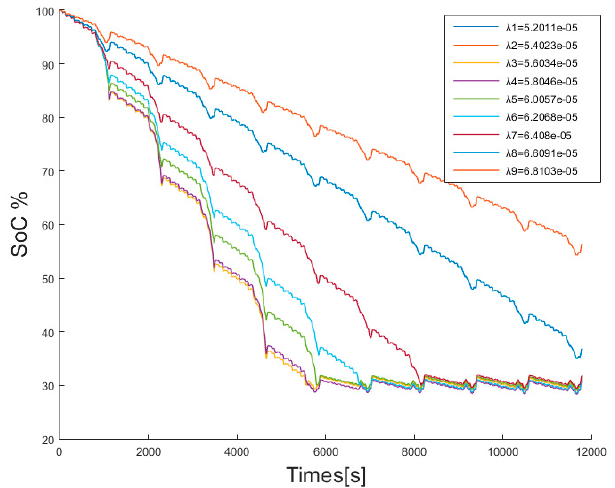
Figure 11. State of the charge variation according to L-Control parameters iteration using the Bisection method in the offline calculation.